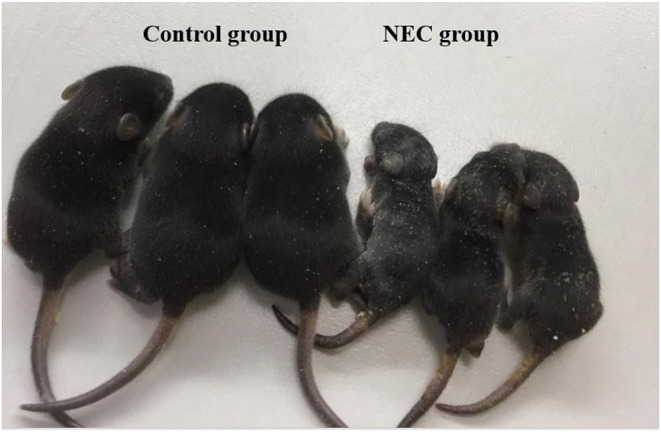
The physical growth of mice in the NEC group and mice in the control group.